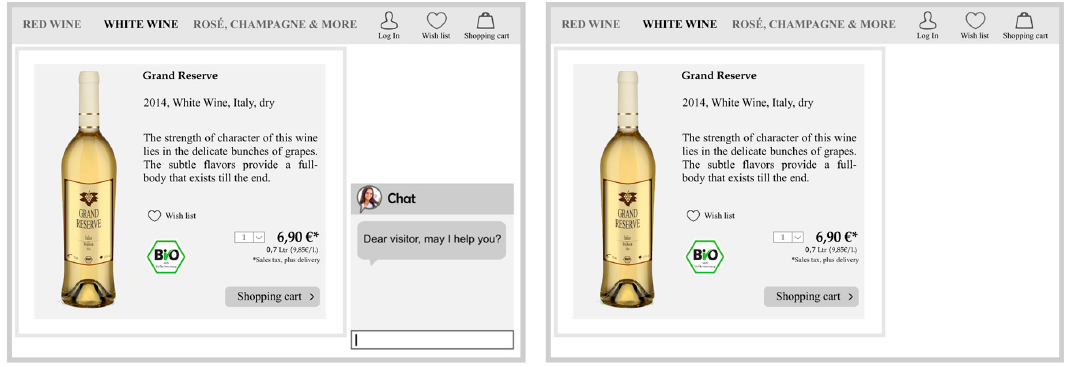
Figure 2. Stimulus material.